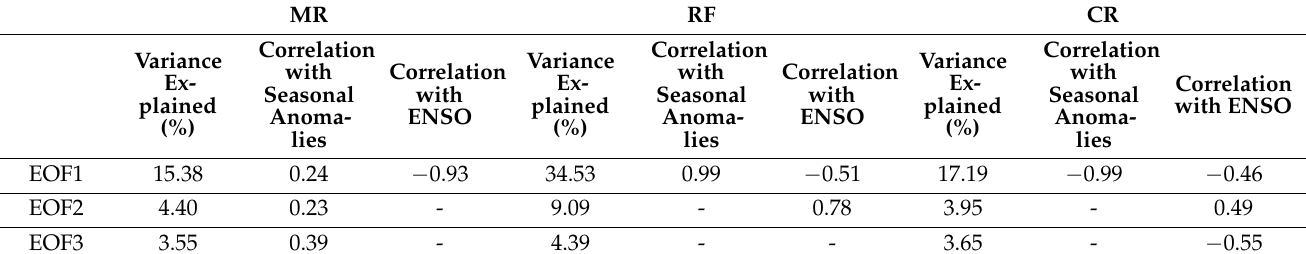
Table 3. Correlation between first three EOFs of precipitation parameters and seasonal anomalies/ENSO. The coefficients that fall below the 95% critical values of 74 samples ( ± 0.23) are not shown.